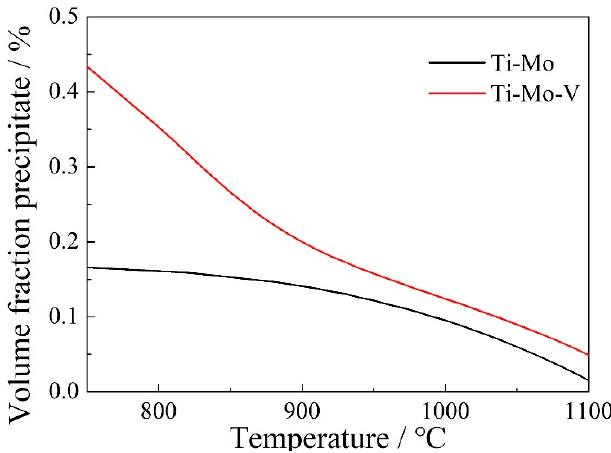
Figure 6. Volume fractions of precipitation in Ti − Mo and Ti − Mo − V steels as a function of tempera- ture in austenite.